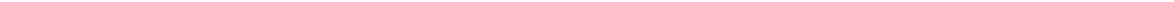
Fig. 2 ERG differentially regulates transcriptional activity of SMAD1 and SMAD3. ERG-dependent regulation of SMAD1 and SMAD3 activity were assessed by transactivation assays using either SMAD1 reporter pGL3-BRE (BRE reporter, a and c ) or SMAD3 reporter pBV-SBE4 (SBE reporter, b and d ). HUVEC were either co-transfected with Control siRNA (Con siRNA) or ERG siRNA for 24 h ( a and b ) or with pcDNA or ERG3 overexpression construct (ERG3) ( c and d ) prior to treatment with TGF β 2 (red) and BMP9 (blue) or PBS (dashed line) for 18 h (data from pooled HUVEC in triplicate experiments). The ratio of luciferase to renilla from each transfection was normalised to PBS-treated control or to groups co-transfected with ( a and b ) Con siRNA or ( c and d ) pcDNA ( n = 3). e Schematic of the inverse regulation of SMAD1 and SMAD3 by ERG. f Protein − protein interactions between ERG, SMAD1, SMAD2 and SMAD3 were assessed by Co-IP assay in whole cell lysate from HUVEC. SB-431542 (SB; 10 μ M) treatment was performed for 1 h and TGF β 2 (10 ng ml − 1 ) or PBS treatments were performed 30 min prior to lysis. Lysates were immunoprecipitated with mouse IgG or mouse α -ERG and then immuno-blotted for α -ERG, α -SMAD1, α -SMAD2, α -SMAD3 and α -pSMAD3 (Ser423/425). Images representative of four experiments. g ERG-SMAD3 interaction was assessed by Co-IP in untreated HSEC. h Cellular localisation of the interaction between ERG with pSMAD3 was investigated by Proximity Ligation Assay (PLA) following 30 min TGF β 2 treatment in HUVEC ( n = 2). i HUVEC or j HSEC were pre-treated with SB-431542 or DMSO prior to transfection with either control siRNA or ERG siRNA for 48 h and analysed by qPCR ( n = 3). Data were normalised to GAPDH and compared to control siRNA treated (*) or to ERG siRNA treated with DMSO (#) by unpaired t -test. All graphical data are mean ± s.e.m., * or # P < 0.05, ** or ## P < 0.01, *** or ### P <